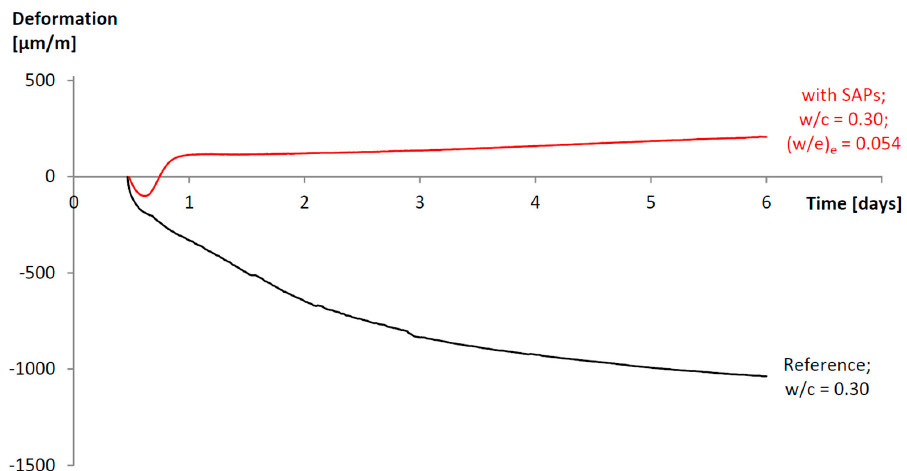
Figure 4. Mitigation of the autogenous shrinkage in a cementitious system with a water-to-cement ratio of 0.30 by means of superabsorbent polymer inclusion. Adapted from [17,78], with permission from © 2015 Elsevier.